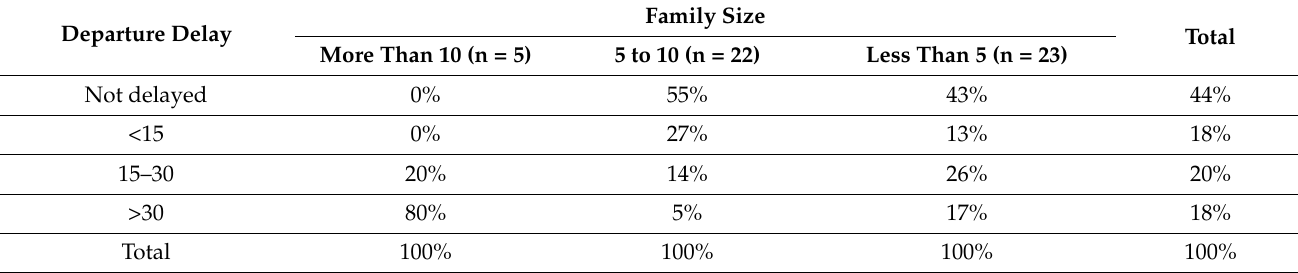
Table 3. Observed percentage frequencies for family size (n = 50).